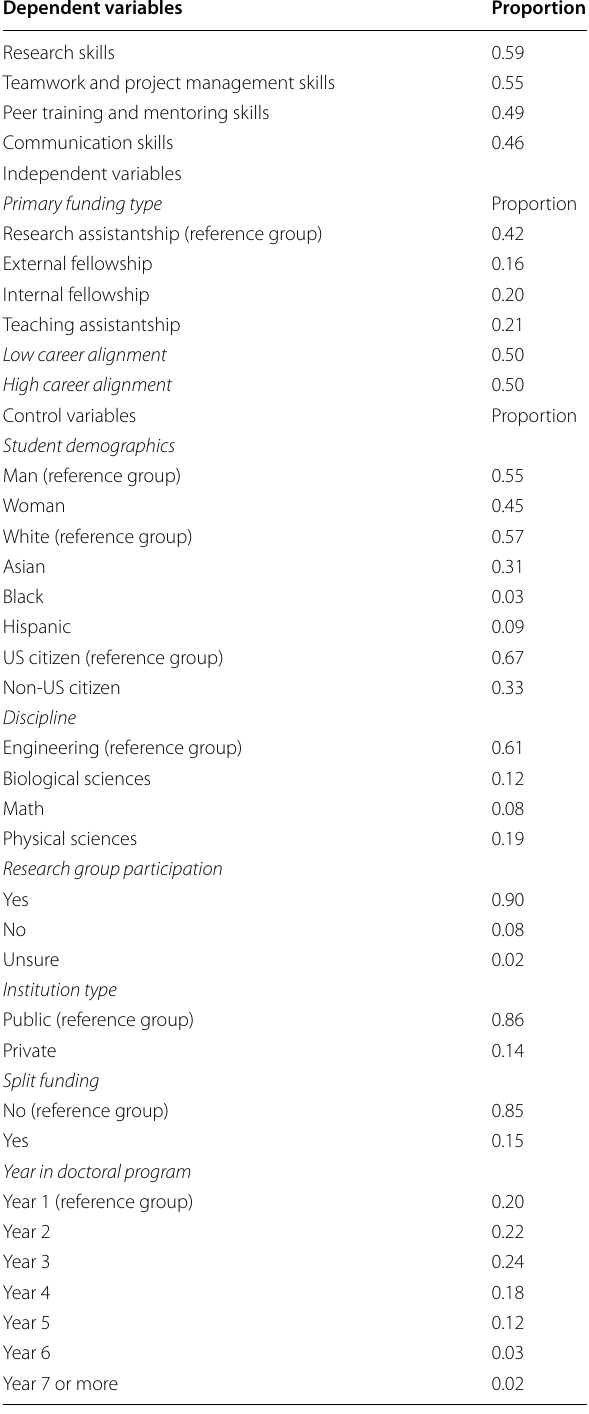
Table 3 Descriptive summary of the dependent,